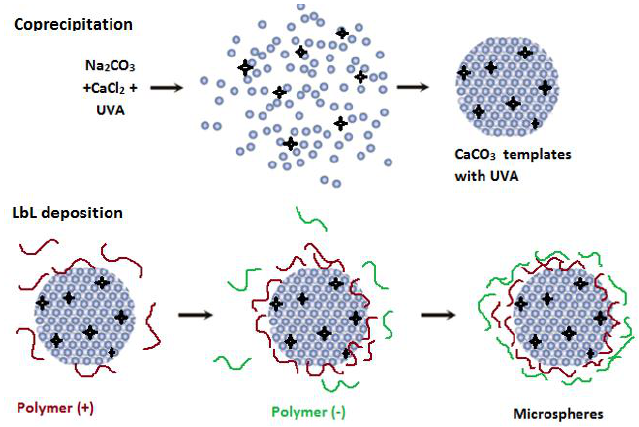
Figure 3. Synthesis of CaCO 3 templates and layer by layer deposition.